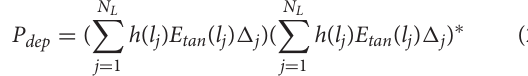
Frontiers in Public Health |